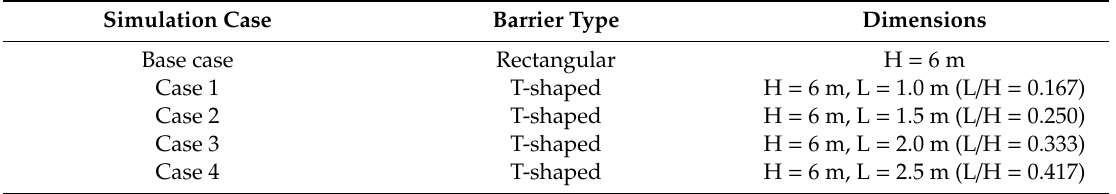
Table 1. Dimensions of noise barriers (full scale).